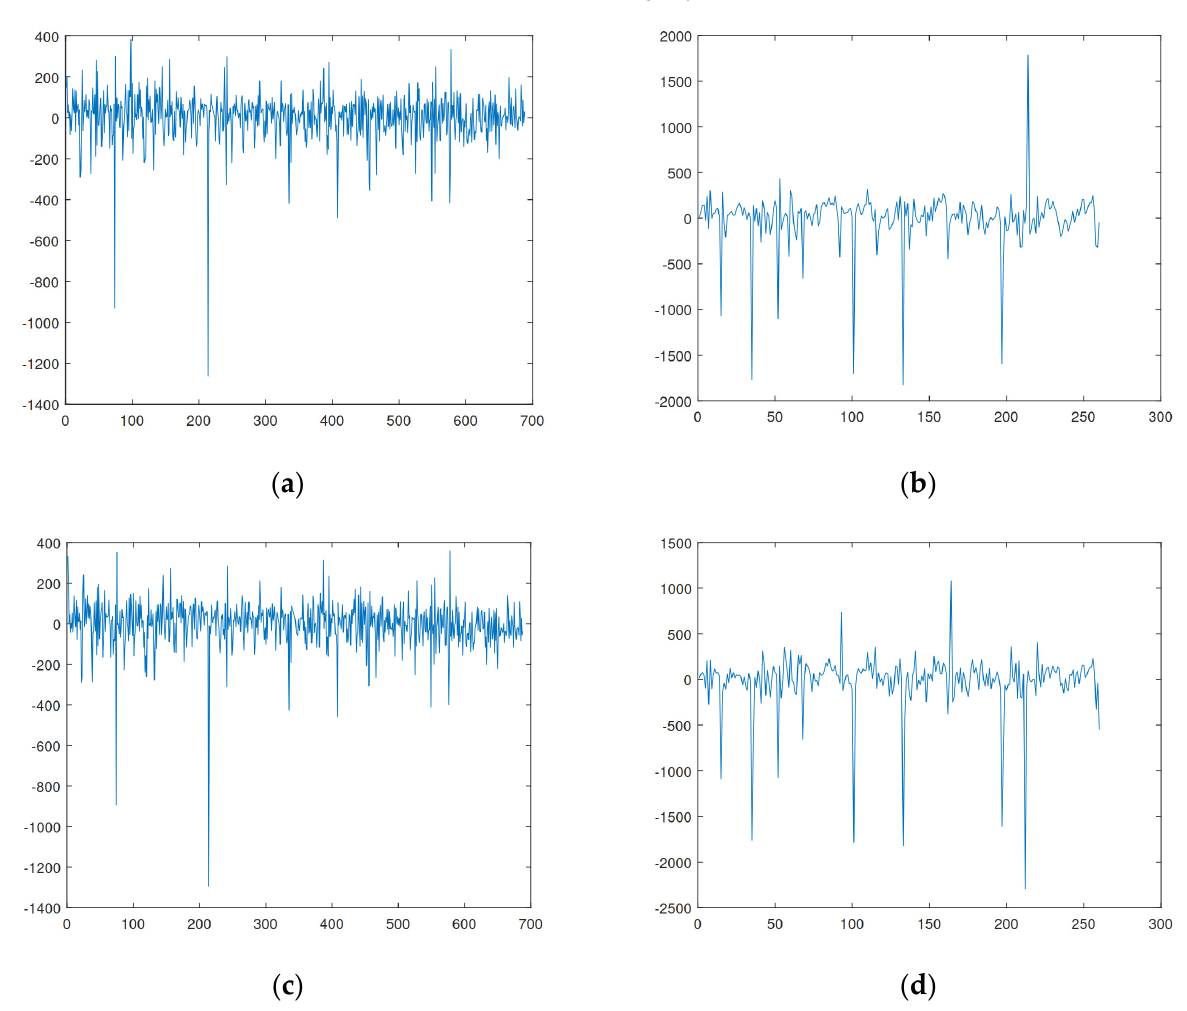
Figure 4. ( a ) H85—Errors of Method II—Workdays; ( b ) H85—Errors of Method II—Weekend; ( c